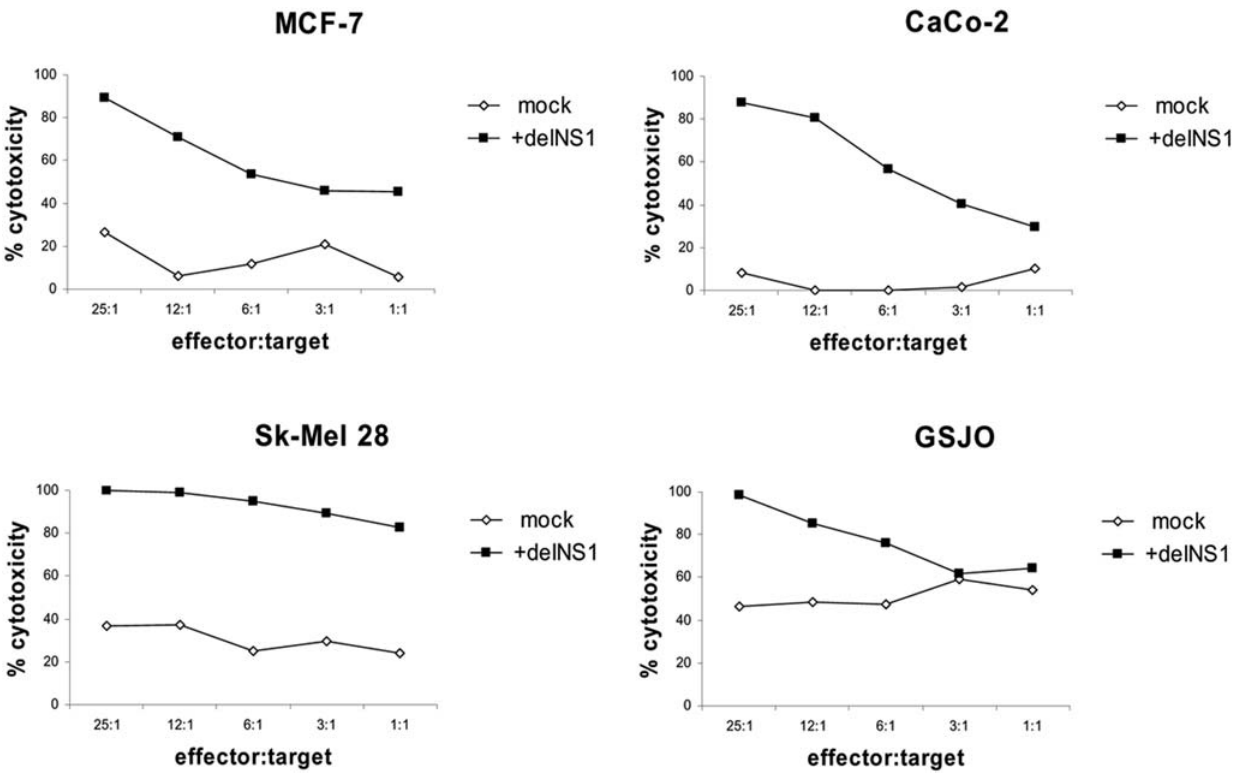
Figure 2. Effect of mock-treated or delNS1 infected PBMCs on tumor cells of different tissue origin. PBMCs were infected with delNS1 virus (m.o.i.=0.02) and kept for 24 hours. Then the PBMCs were co-cultured with the target cells MCF-7, CaCo-2, Sk-Mel 28 or GSJO for 24 hours and cytotoxicity was assessed thereafter. One representative result in percentage of cytotoxicity is shown out of two independent experiments, each performed with PBMCs derived from a different donor.